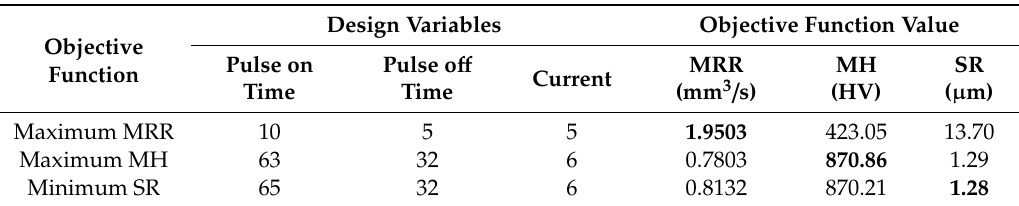
Table 8. Results of single objective optimization.